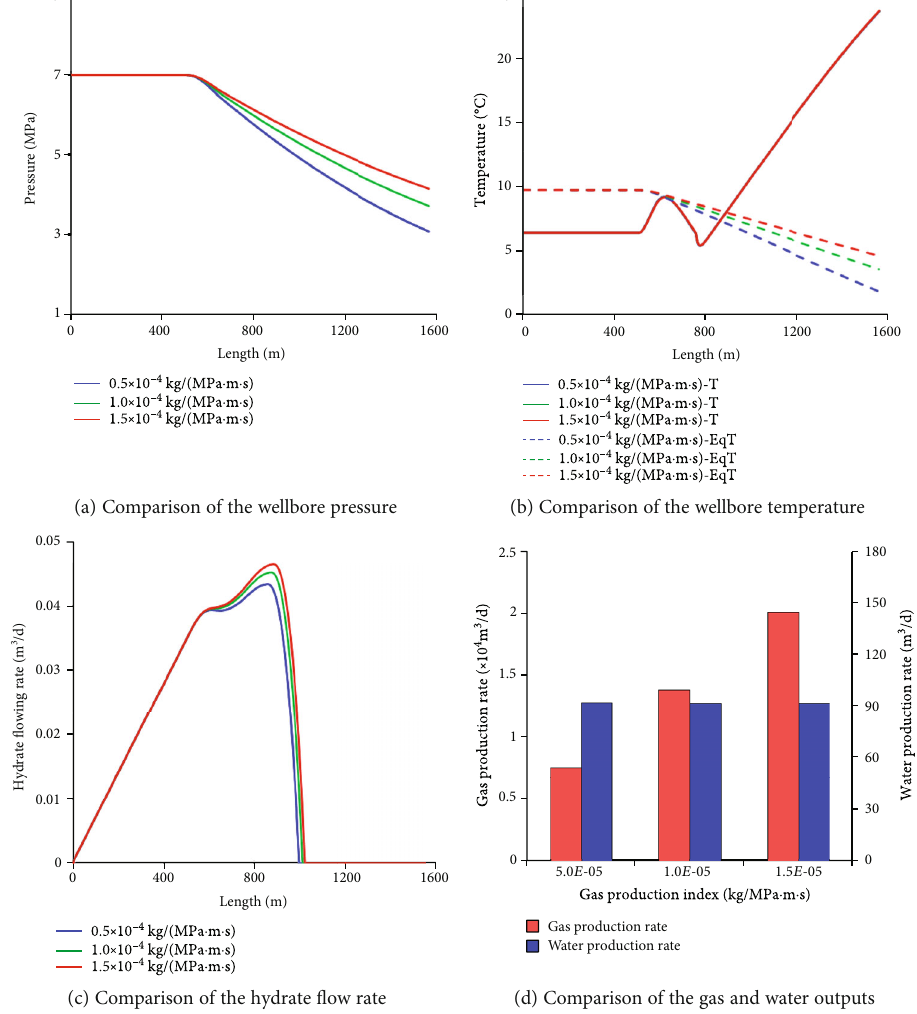
Figure 10: Comparison of each wellbore parameter under di ff erent gas output